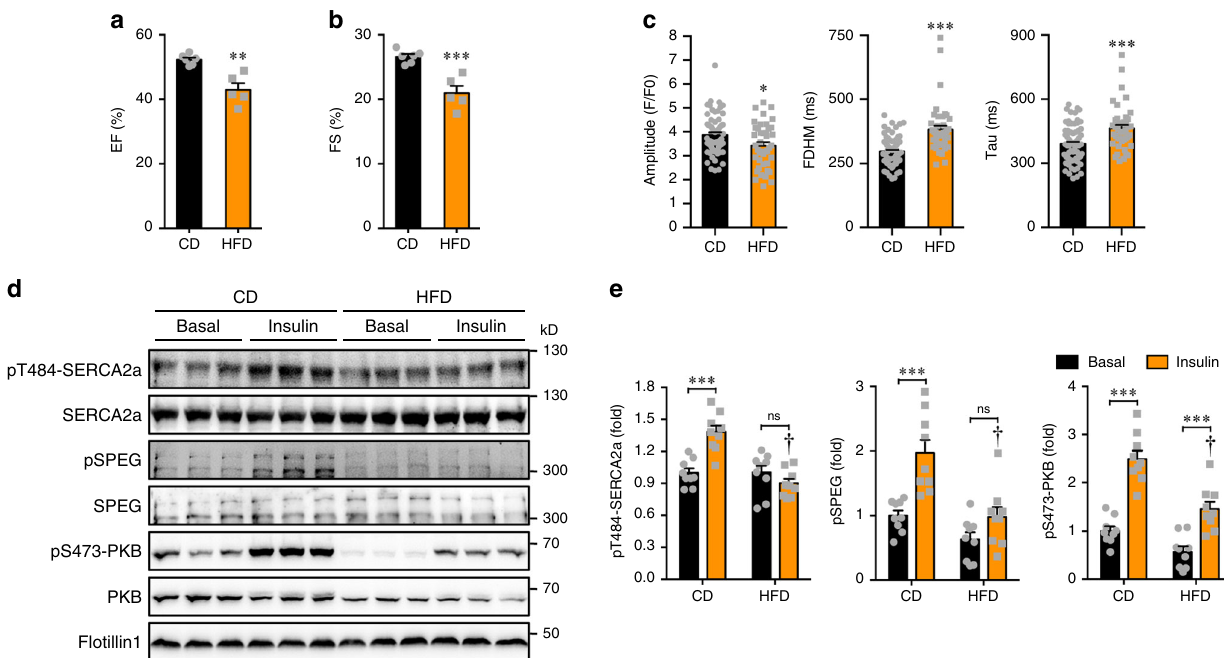
Fig. 6 Effects of HFD on calcium homeostasis and phosphorylation of PKB-SPEG-SERCA2a axis in primary cardiomyocytes. a , b . Ejection fraction (EF, a ) and fractional shortening (FS, b ) in male mice fed with chow diet (CD) or high fat diet (HFD) for 3 months. n = 6 (CD) and 5 (HFD). p = 1.29e-3 (EF) and 7.05e-4 (FS). c Calcium transients in primary cardiomyocytes isolated from male mice fed with CD or HFD upon electrical stimulation. 64 cells from CD- fed mice and 42 cells from HFD-fed mice were analyzed. p = 1.24e-2 (amplitude), 1.79e-7 (FDHM), and 2.52e-4 (Tau). D-E. Phosphorylation of PKB, SPEG and SERCA2a in primary cardiomyocytes isolated from CD- or HFD-fed mice in response to insulin. Phosphorylation of PKB, SPEG and SERCA2a was normalized with their respective total proteins. Represent blots were shown in d , and quantitative data were shown in e . n = 9. The data are given as the mean ± SEM. Statistical analyses were carried out using two-sided t -test for a – c , and two-way ANOVA for e . One-asterisk indicates p < 0.05, two-asterisk indicates p < 0.01, and three-asterisk indicates p < 0.001. One-dagger (CD insulin vs HFD insulin) indicates p < 0.001. Source data are provided as a Source Data fi